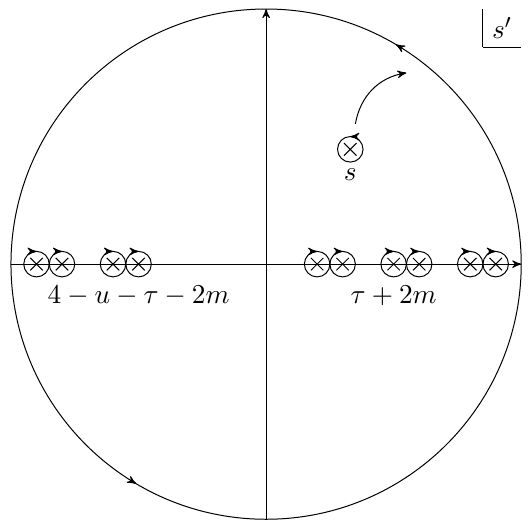
Figure 1 . Contour deformation determining the sum